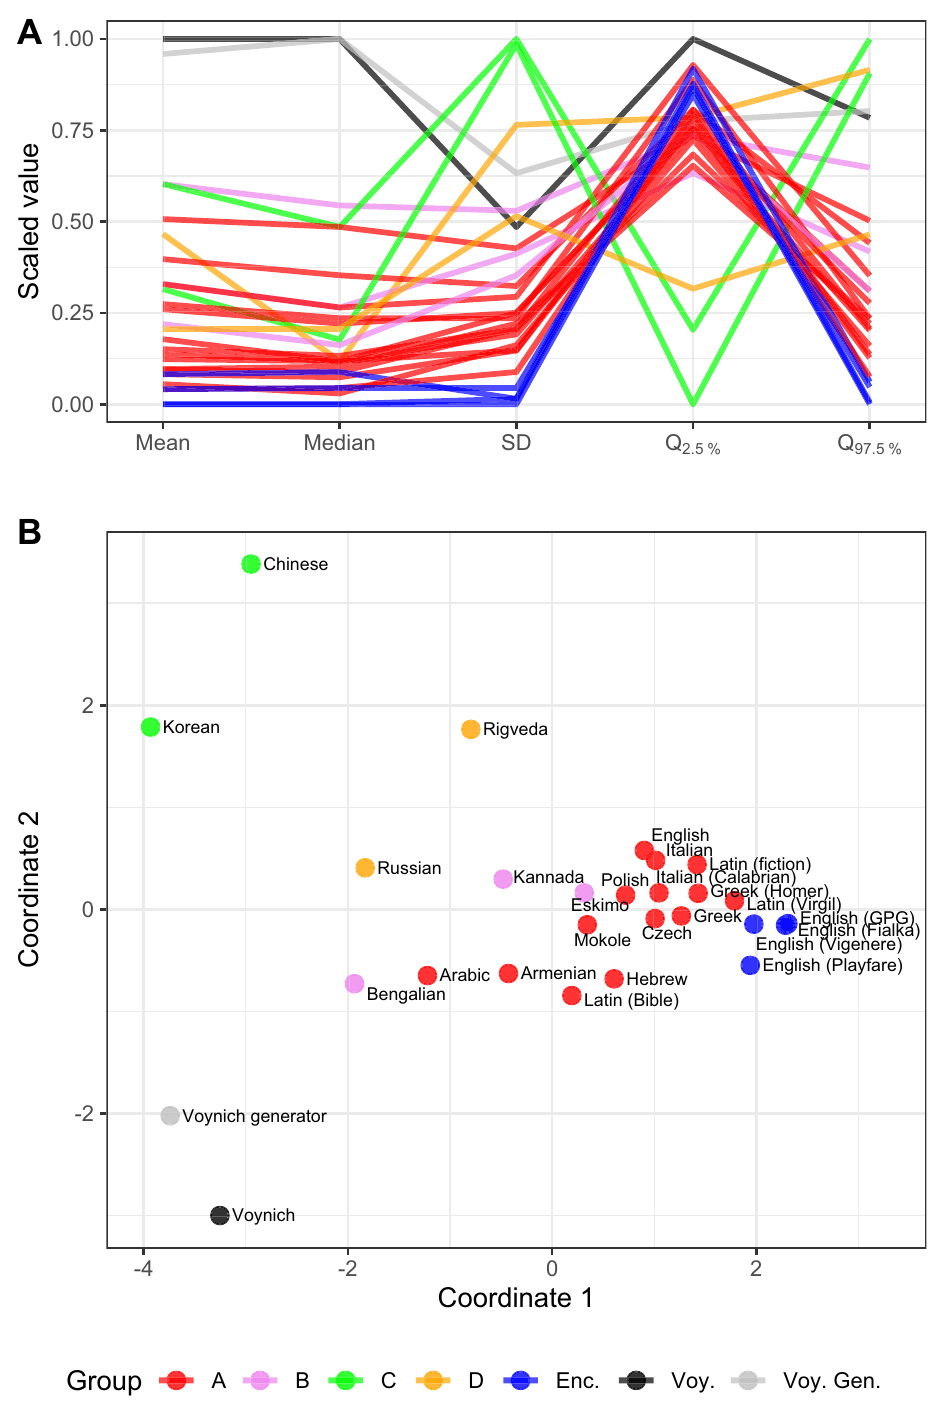
Fig 5. ACF summarization data visualization. Parallel coordinate plot (chart A) and multidimensional scaling plot (MDS; chart B) of Symbol repetition delays ACF summarization data for various language and text samples listed in Table 4. Data were scaled by min-max scaling and Euclidean distances were used for plotting the MDS. MDS explains 96.8% of the original variance. Voynich Manuscript along with the Voynich Manuscript imitation are dissimilar to the rest of the tested texts, create anti-patterns (visible in chart A) and form its own clusters (visible in chart